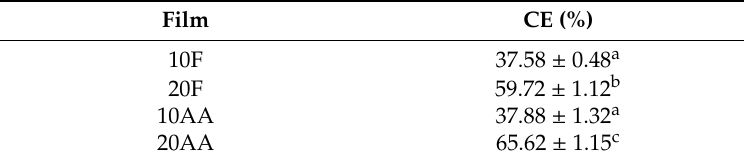
Table 2. Cross-linking extension (CE) of gelatin films as a function of cross-linker type and content.